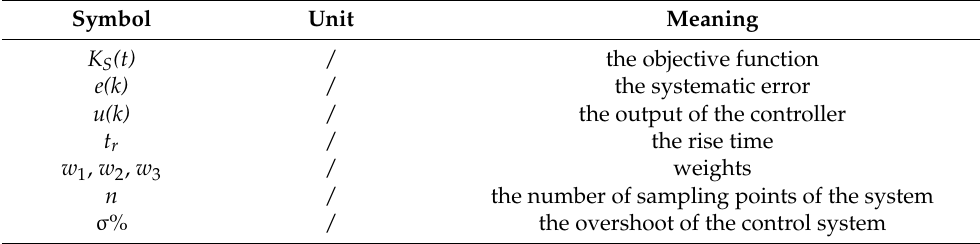
Figure 3. Schematic diagram of mutual window control theory in the continuous drying process. Table 8. Formula (9) symbols and